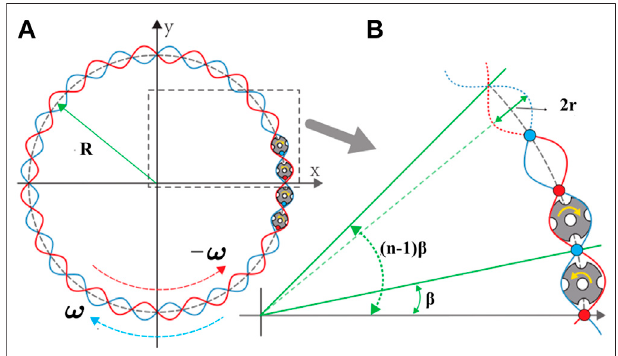
FIGURE 2 | The schematic path of the bobbin movement. (A) There are totally 32 bobbins revolving around the mandrel in the bobbin planes with a diameter of 2R. With the angular speed of ω , half of them are moving clockwise,whiletheotherhalfaremovinganticlockwise.Thetwogroups of yarns interlock, forming a biaxial fabric. Approximately, the actual path of a bobbin fi tsasinusoidal. (B) The position and displacementofa certain bobbin is the function of β and its index n . The bobbin is driven by the horn gear that has a diameter of